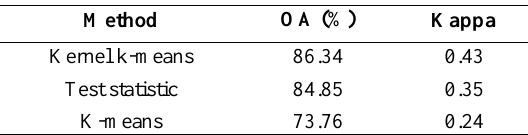
Table 2 Performance evaluation of the change